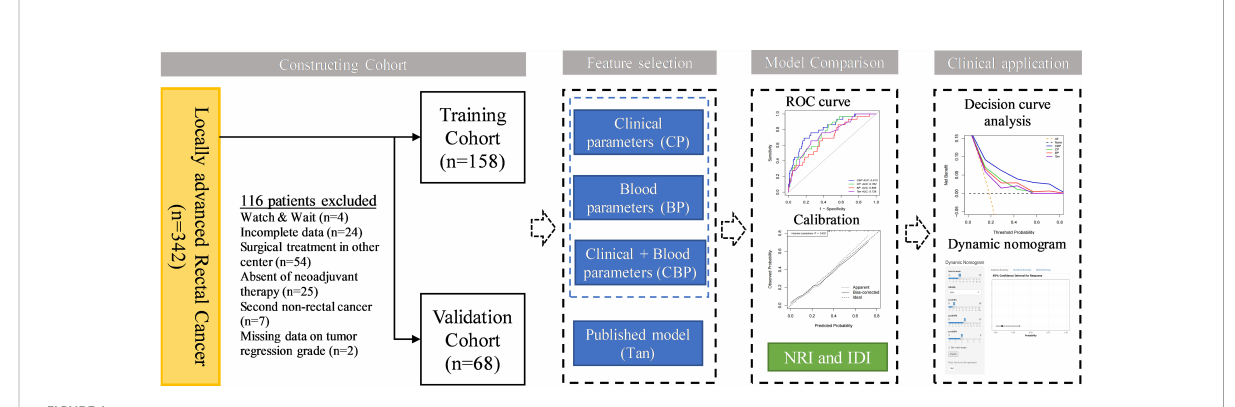
FIGURE 1 Flow chart of the